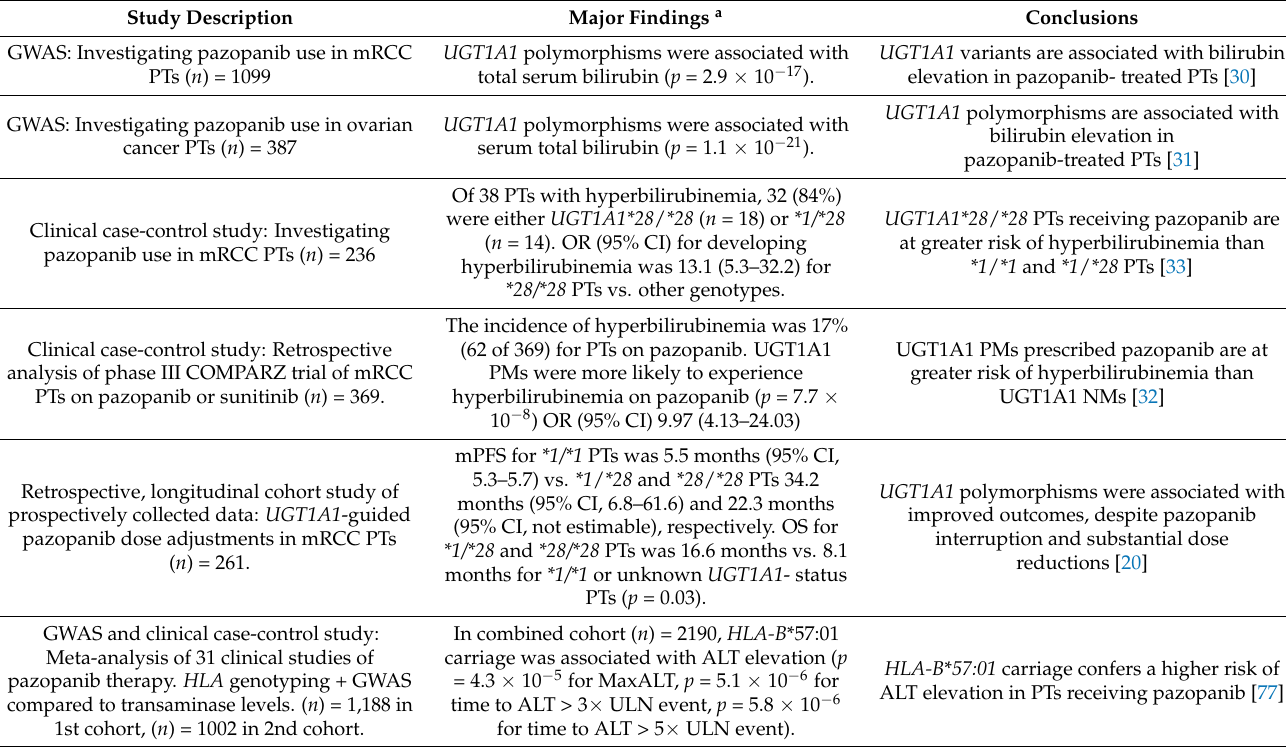
Table 4. Pharmacogenetic influence of UGT1A1 or HLA-B*57:01 on hepatotoxicity with use of